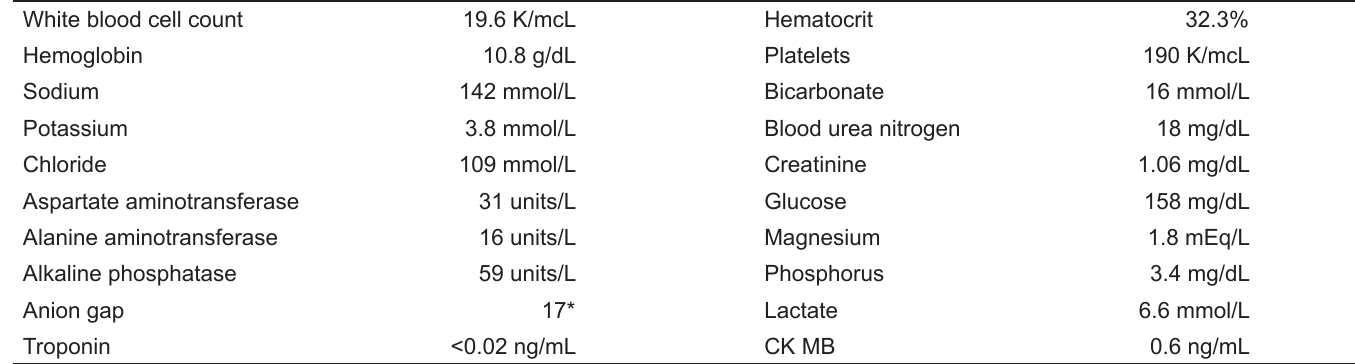
Table 1. Hematology, chemistry and cardiac studies in patient with bilateral lower extremity weakness.